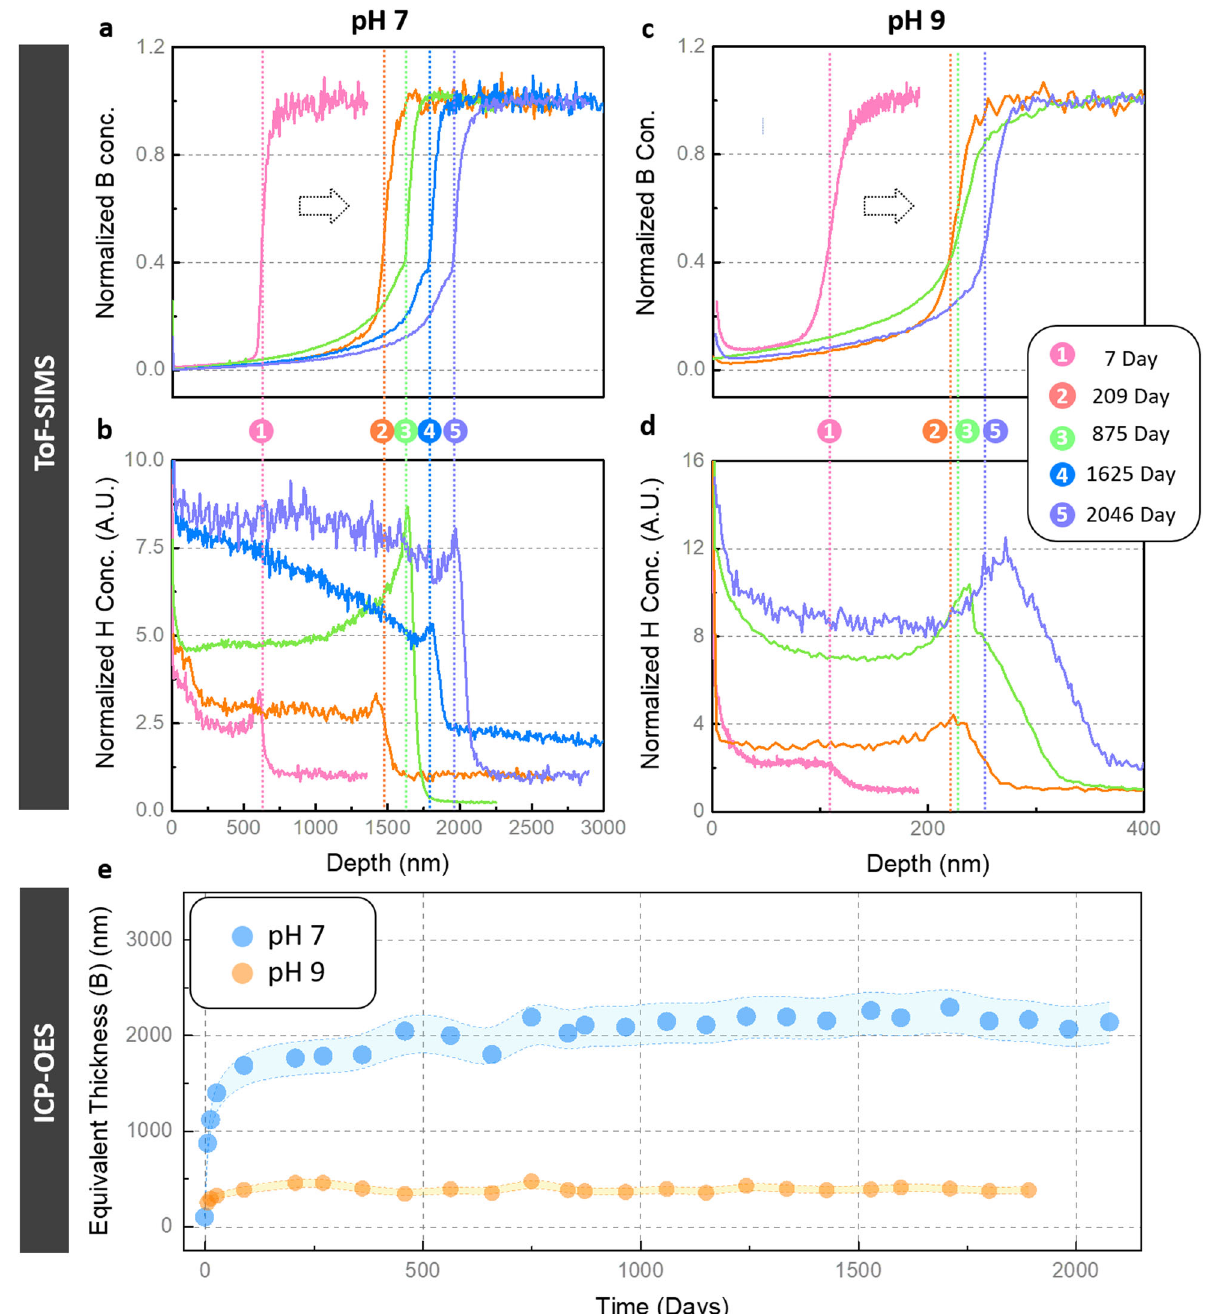
Fig. 1 Solid and solution data from Experiment 1 conducted with ISG specimens corroded at 90 °C in a silica-saturated solution at pH 7 or 9. a , b ToF-SIMS pro fi les of B and H at various durations for the test conducted at pH 7. For B, intensities were normalized to that of Zr, an immobile element, and the resulting ratio was normalized to the mean value of B/Zr in the pristine glass. For H, intensities were normalized to the mean value in the pristine glass. Therefore, B data are quantitative whereas H data are qualitative. c , d Same as a-b for the test conducted at pH 9. In a – d , vertical dashed lines are placed at C(B) = 0.5 (boundary between the bulk gel and the active zone). The shift of the H front with time is clearly visible at pH 9. e Gel thickness calculated from B release in